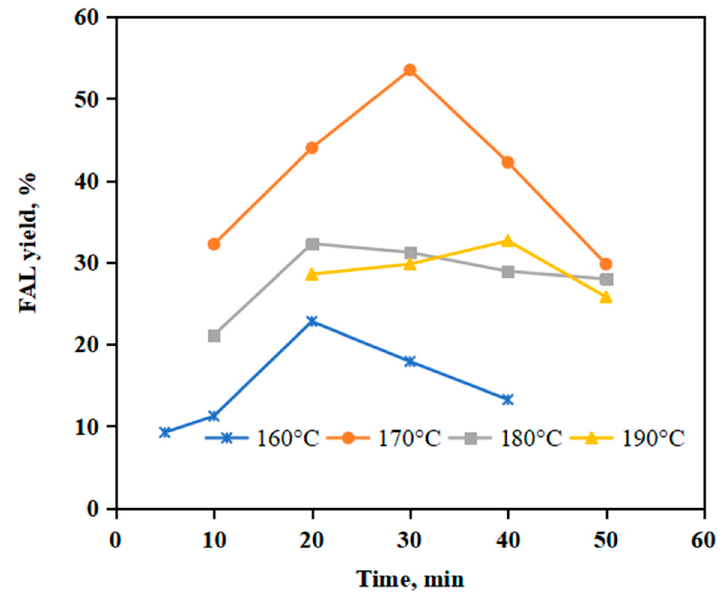
Figure 7. Effects of reaction temperature (160, 170, 180, and 190 °C) and reaction time (5–50 min) on